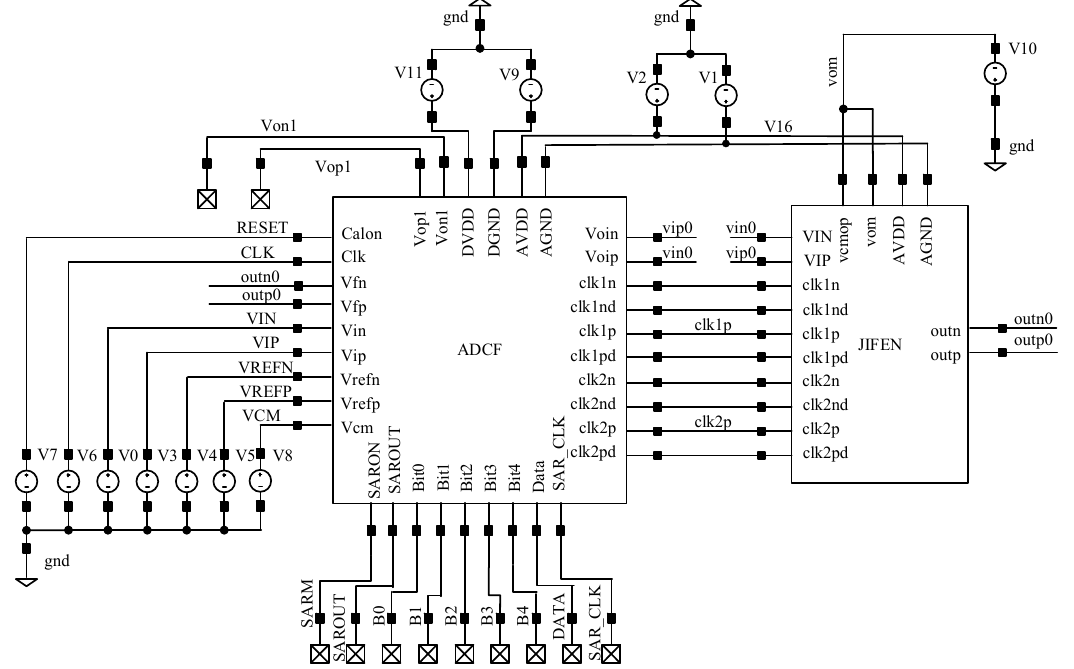
Figure 11. Overall simulation structure diagram of the modulator.